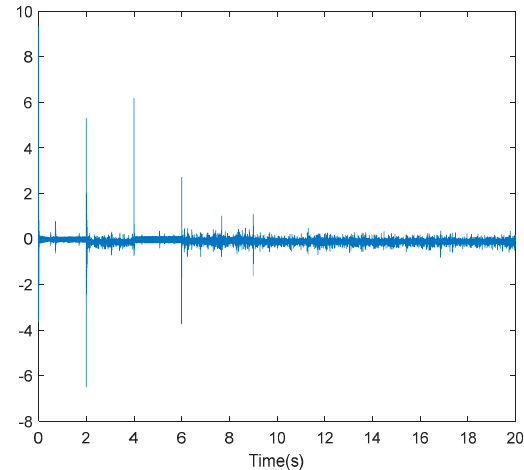
Figure 18. Current